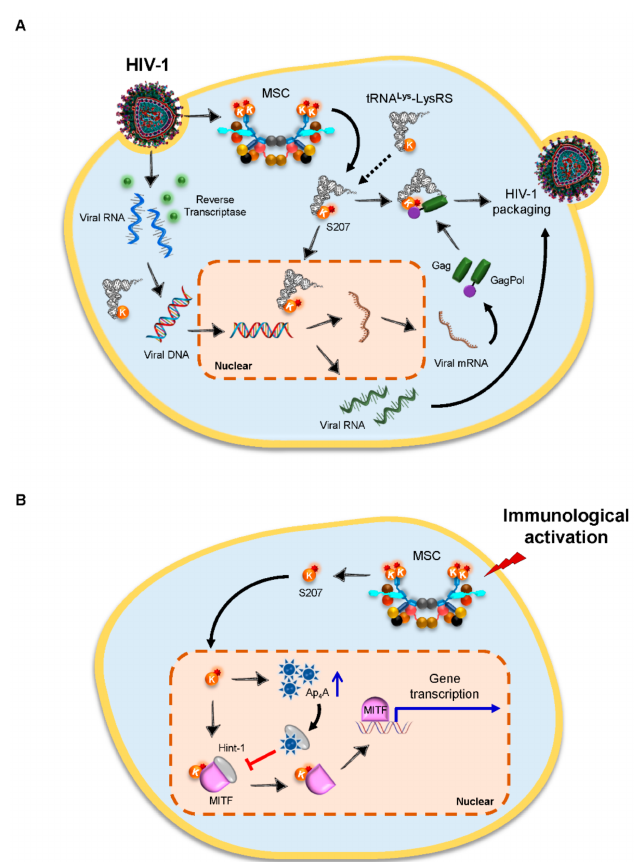
Figure 3. LysRS in HIV-1 infection. ( A ) After HIV-1 infection, the RNA genome of HIV-1 is converted to DNA, which is primed by the host cellular tRNA Lys . Human LysRS is also packaged into HIV-1 virions via the interaction with the viral precursor proteins Gag and GagPol. On the other hand, HIV-1 infection triggers the release of LysRS from the MSC via the phosphorylation of serine 207 (S207) (red star) in LysRS. The released LysRS partially translocates to the nucleus. HIV-1, human immunodeficiency virus type 1; LysRS (K), lysyl-tRNA synthetase; and MSC, multi-synthetase complex. ( B ) In immunoglobulin E (IgE)-stimulated mast cells, LysRS is phosphorylated at S207, followed by its release from the MSC. The dissociated LysRS further traffics to the nucleus, where it forms a complex with MITF and Hint-1, as well as produces high levels of Ap 4 A (blue arrow). The interaction between Ap 4 A and Hint-1 results in the dissociation of Hint-1 from the complex and the activation of MITF-targeted gene transcription. Ap 4 A, diadenosine tetraphosphate and MITF, microphthalmia transcription